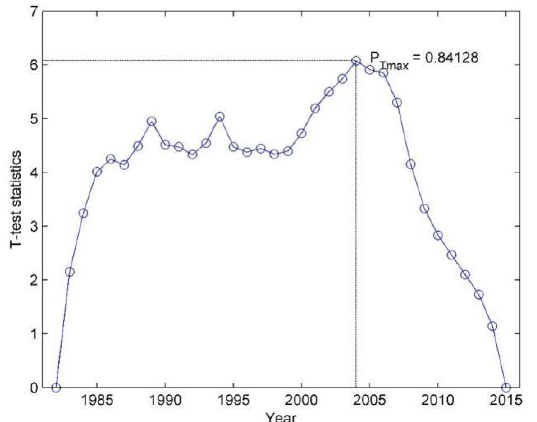
Figure 4. The B – G segmentation algorithm results for the NDVI data in the MUHR from 1982 to 2015.